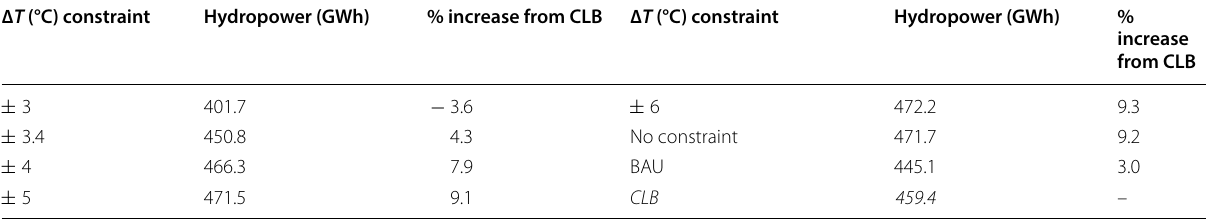
The benefits are compared in terms of percent increase in generation over the benchmark of CLB scenario for the year 2014